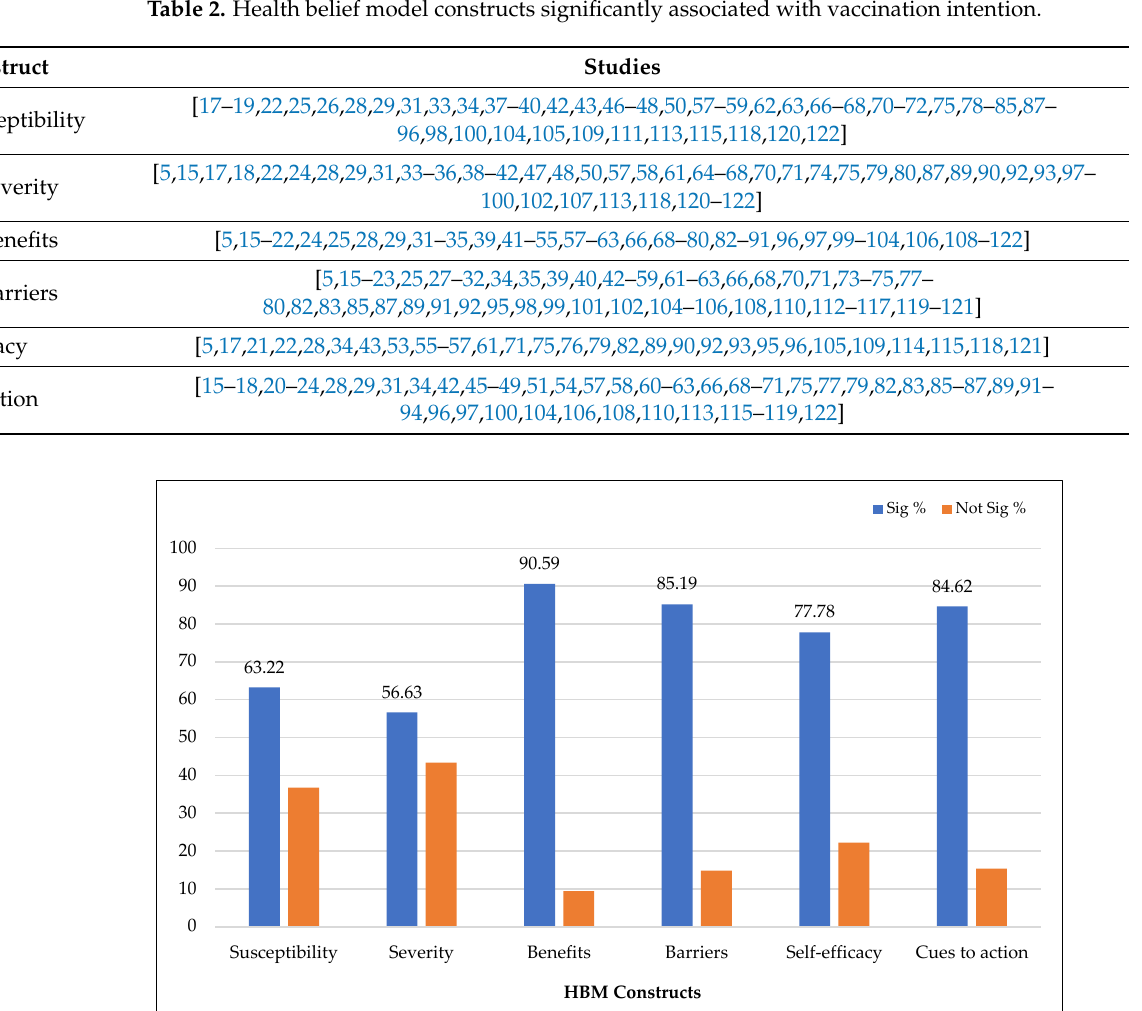
Table 2. Health belief model constructs significantly associated with vaccination intention.